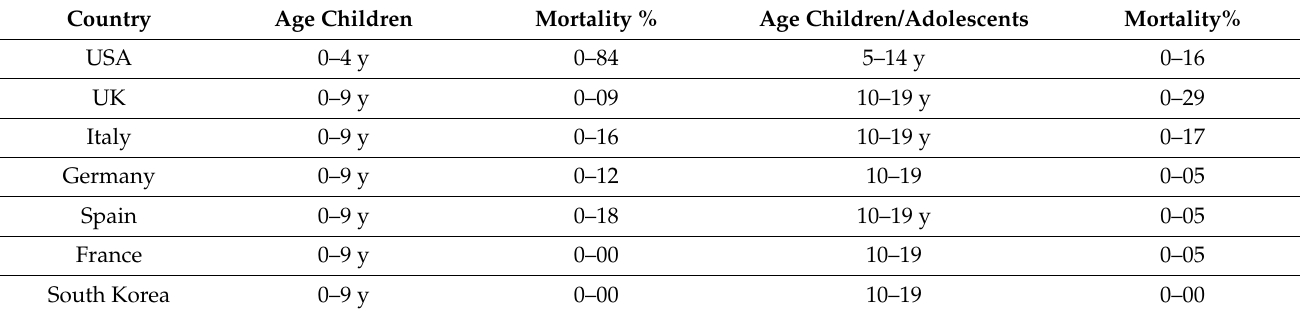
Table 1. Pooled data from different countries for 100.000 children related to COVID-19 deaths [11].